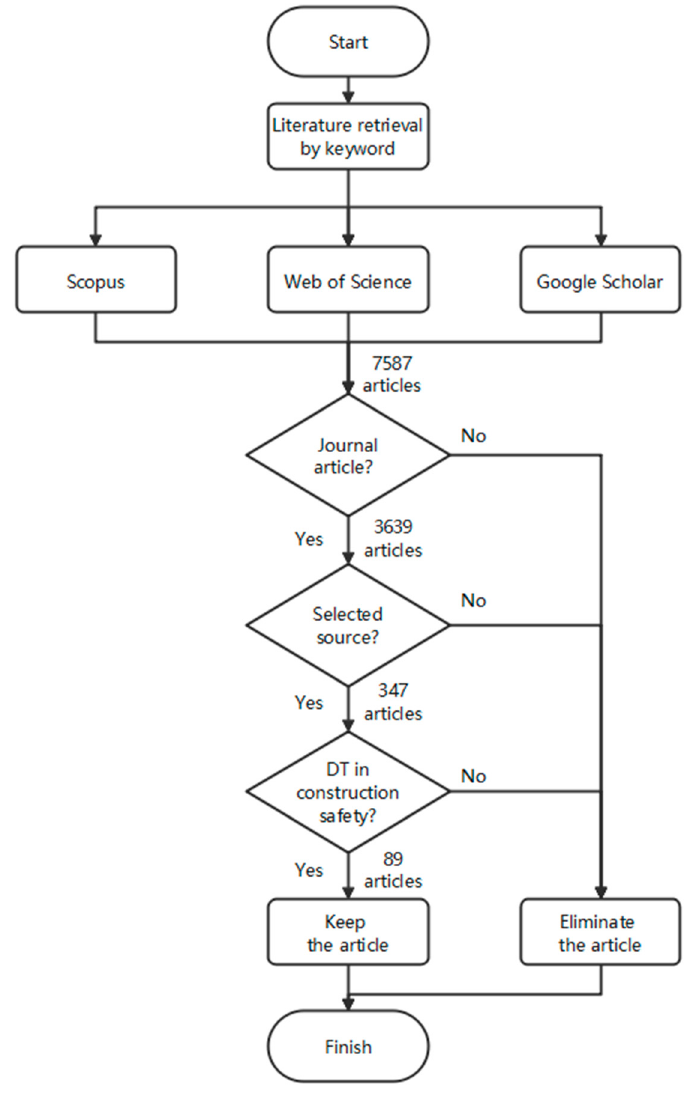
Appl. Sci. 2021 , 11 , x FOR PEER REVIEW Figure 2. Literature retrieval process. Figure 2. Literature retrieval process.